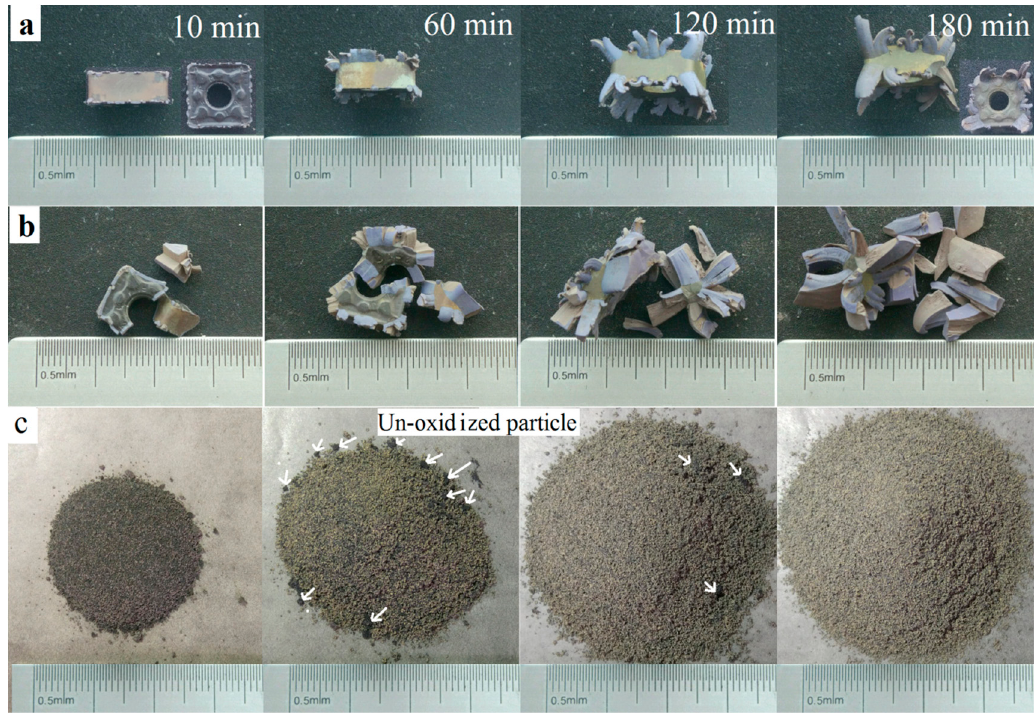
Figure 3. Macrographs of samples oxidized at 900 °C in air for different times. ( a ) Untreated samples; ( b ) fragmented samples; and ( c ) milled powders.